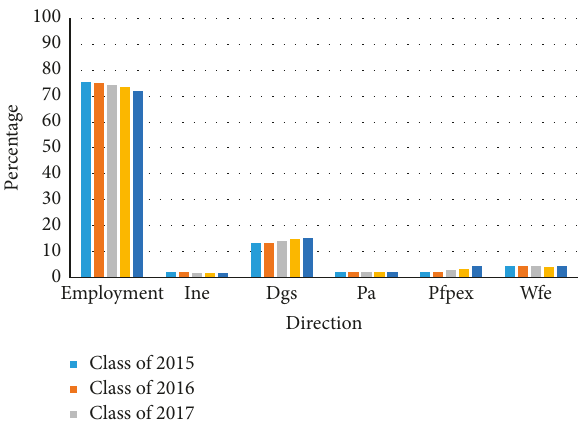
Figure 4: Distribution of undergraduate graduates in recent years. Ine: innovation and entrepreneurship. Dgs: domestic postgraduate. Pa: postgraduate study abroad. Pfpec: prepare for postgraduate entrance examination. Wfe: to be